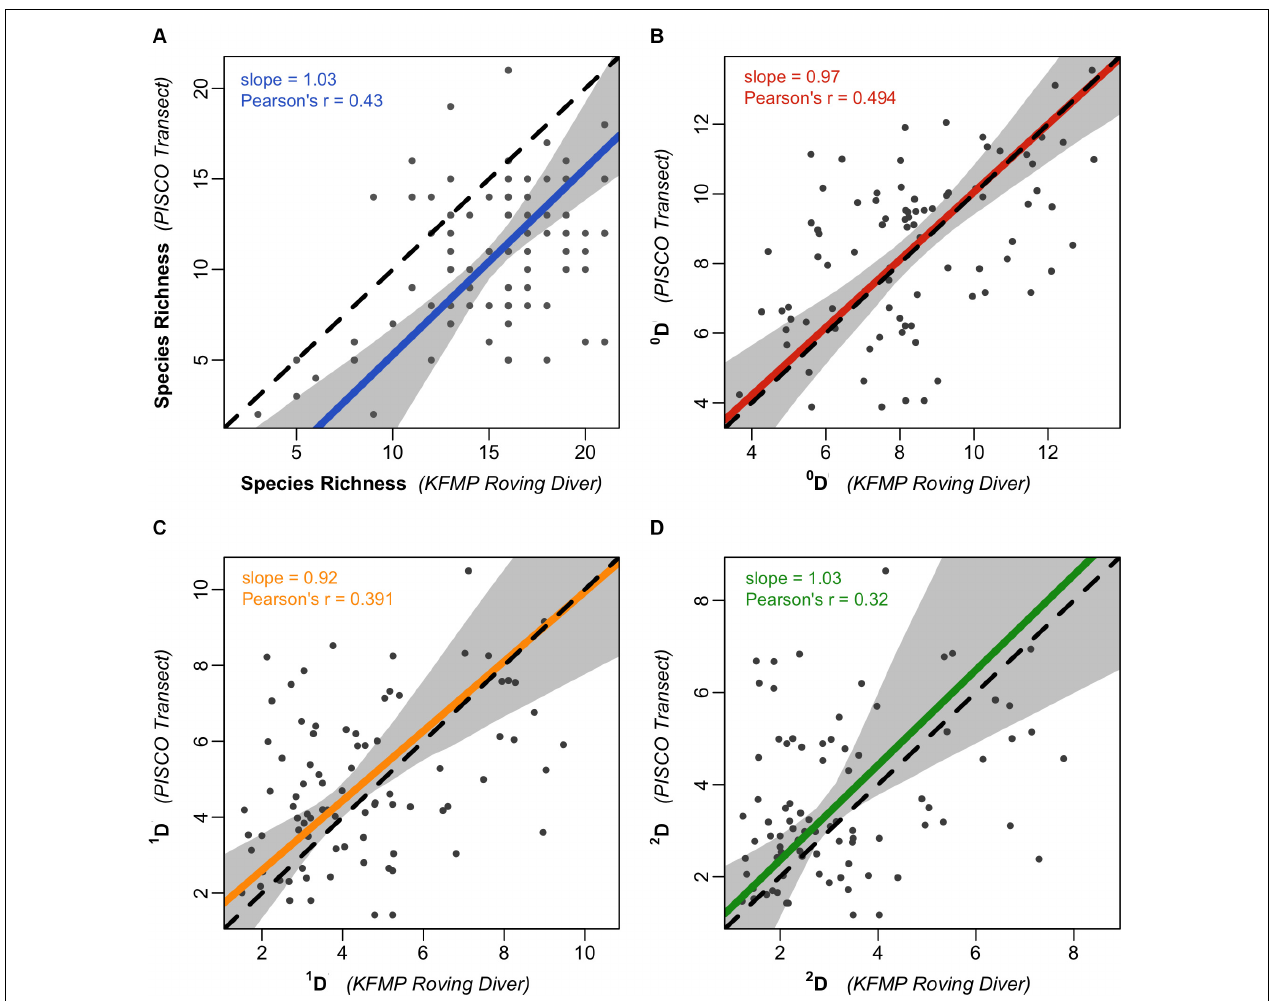
FIGURE 3 | Diversity metrics for the two fish survey methodologies. Scatterplots representing (A) the relationship of raw species richness between paired KFMP roving diver counts and PISCO transects ( n = 241 paired sampling events). Remaining plots represent similar analyses for (B) 0 D, (C) 1 D, and (D) 2 D, each rarefied and extrapolated/interpolated to 50 individuals ( n = 85 for plots B–D ). In each plot the solid line represents a Deming linear regression and the dashed line represents the 1:1 line. The 0.95 confidence bounds are calculated with the bootstrap (quantile) method. All 72 taxa are